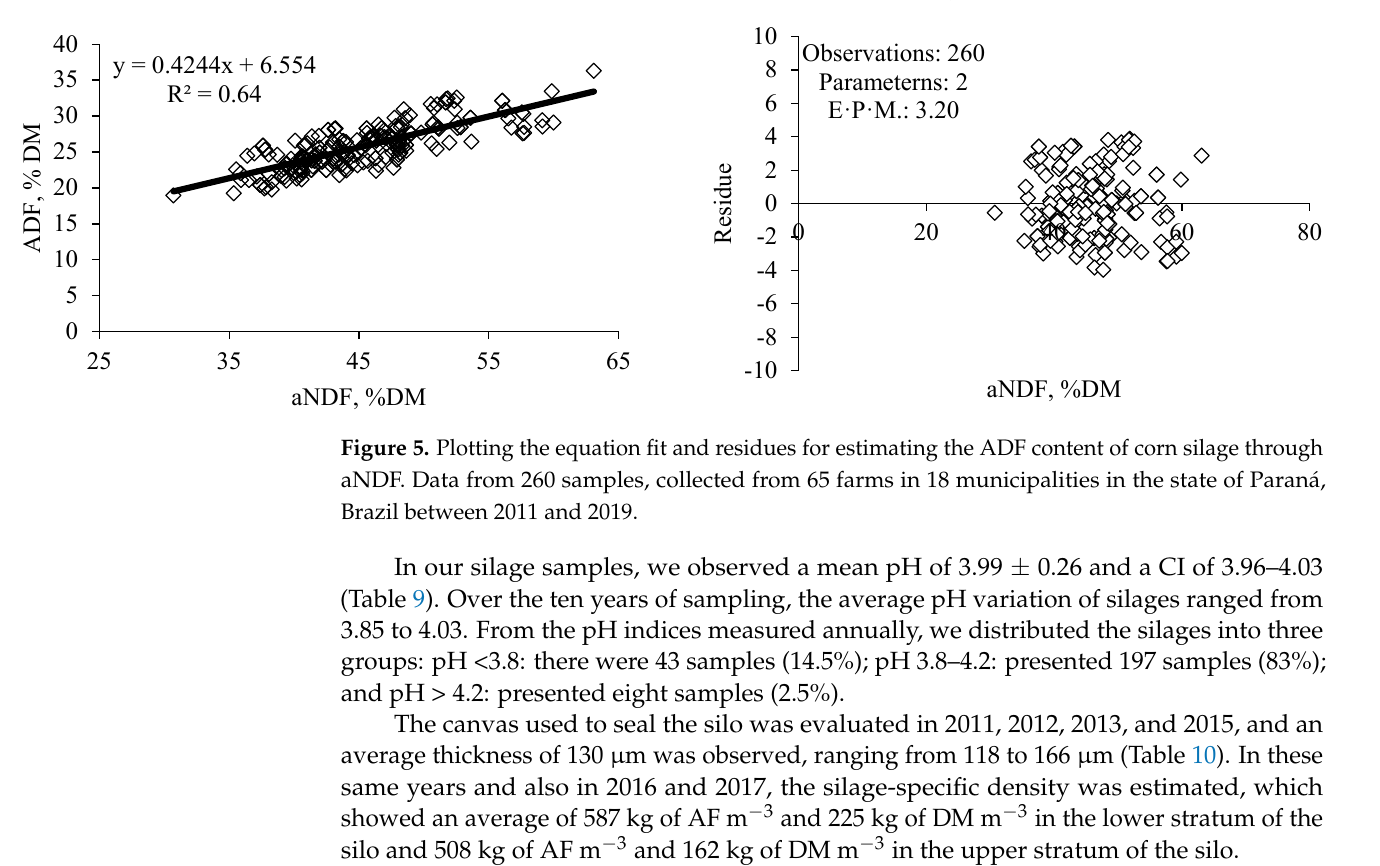
Table 9. Corn silages’ pH index (mean ± SD) sampled in the state of Paraná, Brazil in ten summer crops (2011–2020).